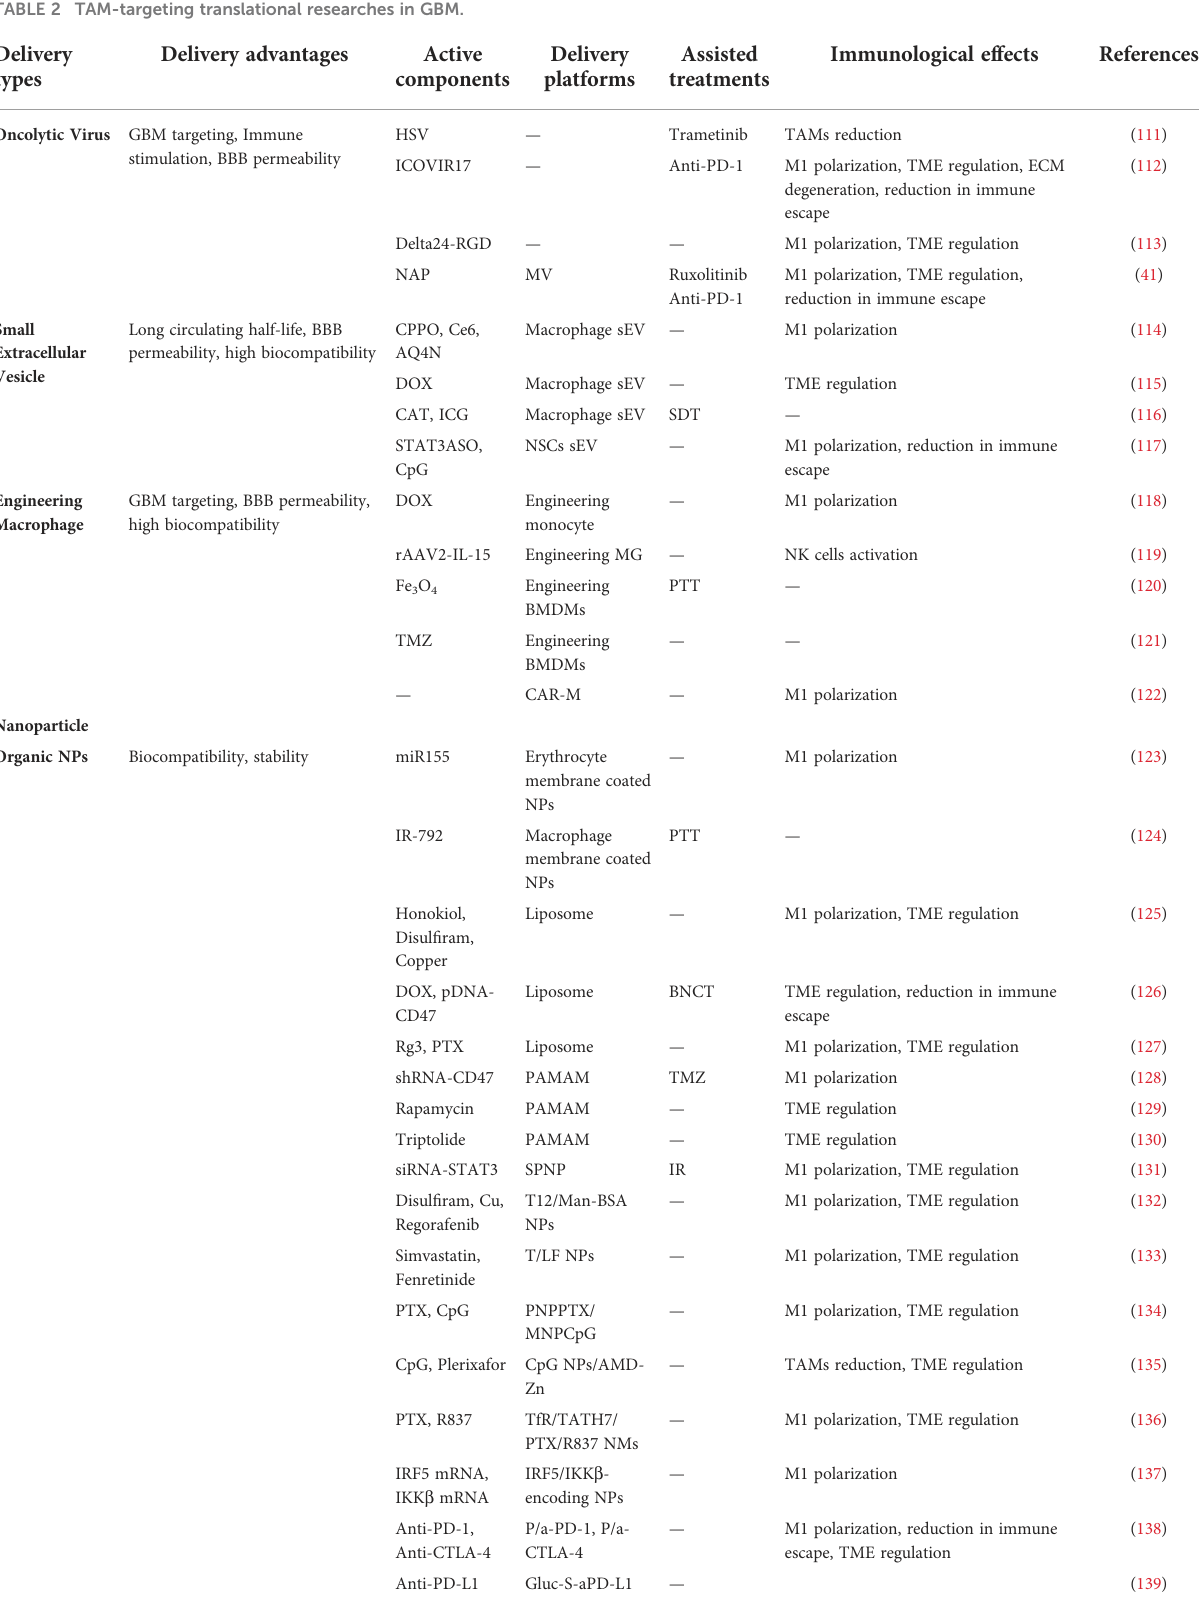
TABLE 2 TAM-targeting translational researches in